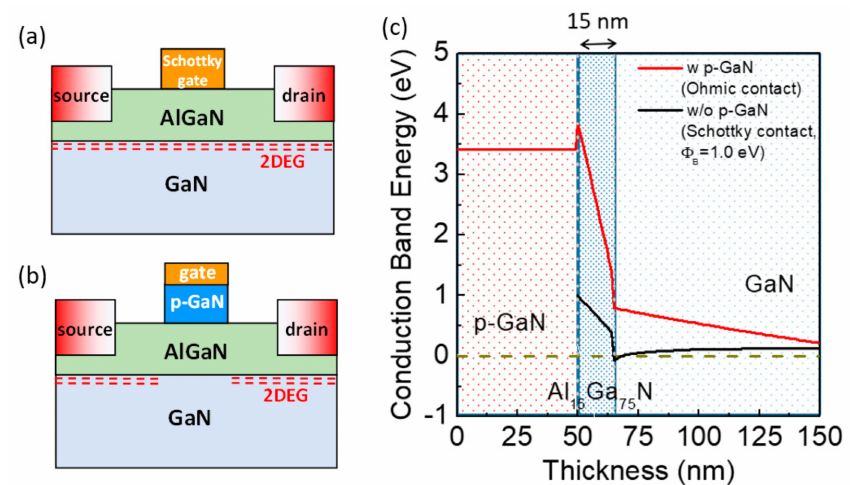
Figure 3. Schematic of a normally-on HEMT with a Schottky gate ( a ) and normally-o ff HEMT with a p-GaN gate ( b ); conduction band diagrams of a p-GaN / AlGaN / GaN heterostructure simulated for a p-GaN layer (3 × 10 19 cm − 3 ) of 50 nm, an AlGaN thickness of 15 nm and Al concentration of 15% ( c ). The Fermi level (dashed line) lies below the conduction band, which indicates the depletion of the two-dimensional electron gas (2DEG) and a normally-o ff condition. For comparison, the band diagram of an AlGaN / GaN heterostructure with a conventional Schottky gate is reported